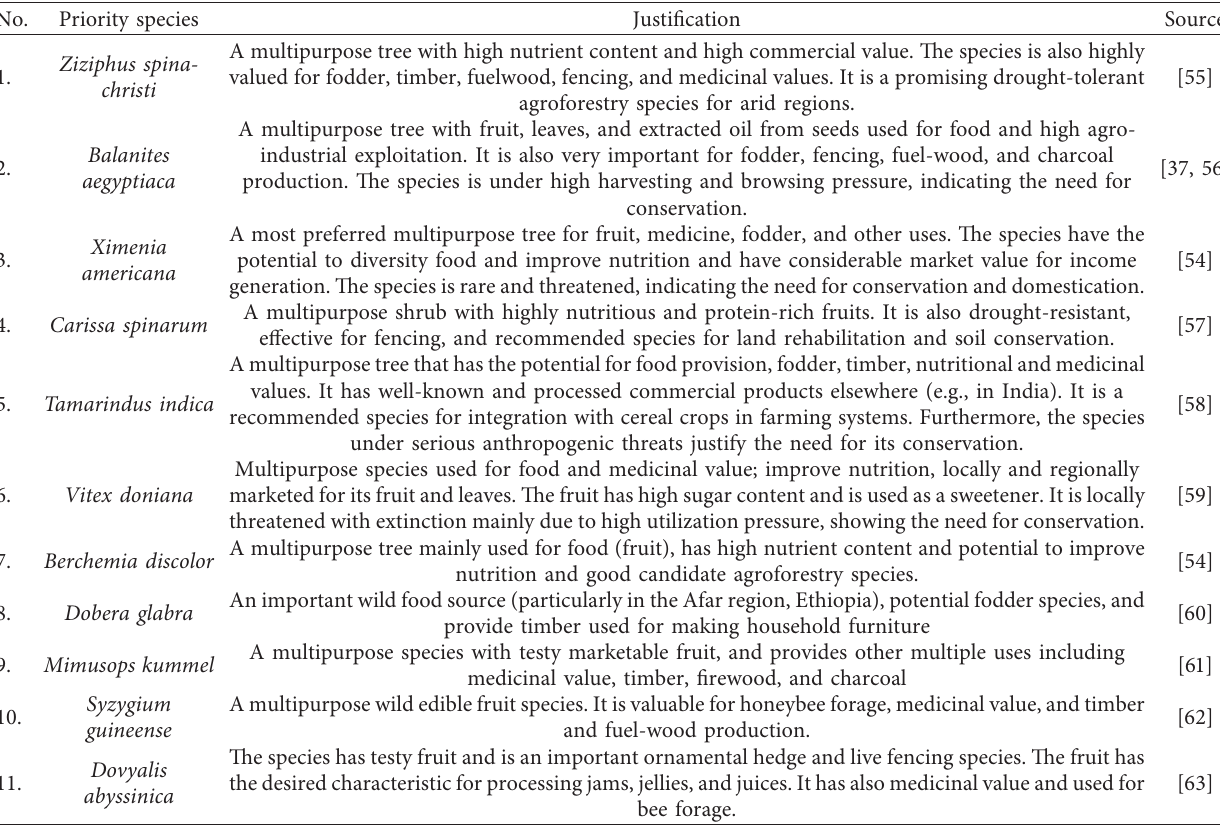
Table 5: Suggested priority wild edible fruit species for domestication and improvement in